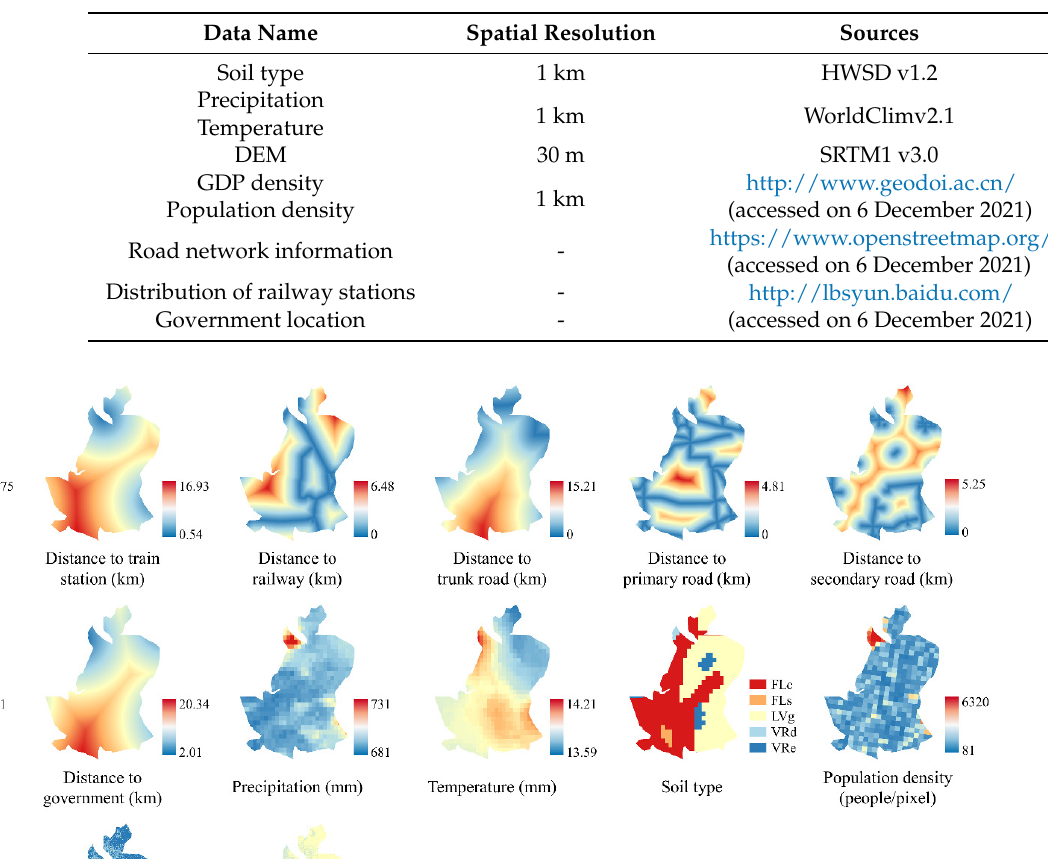
Table 1. Description of spatial data.